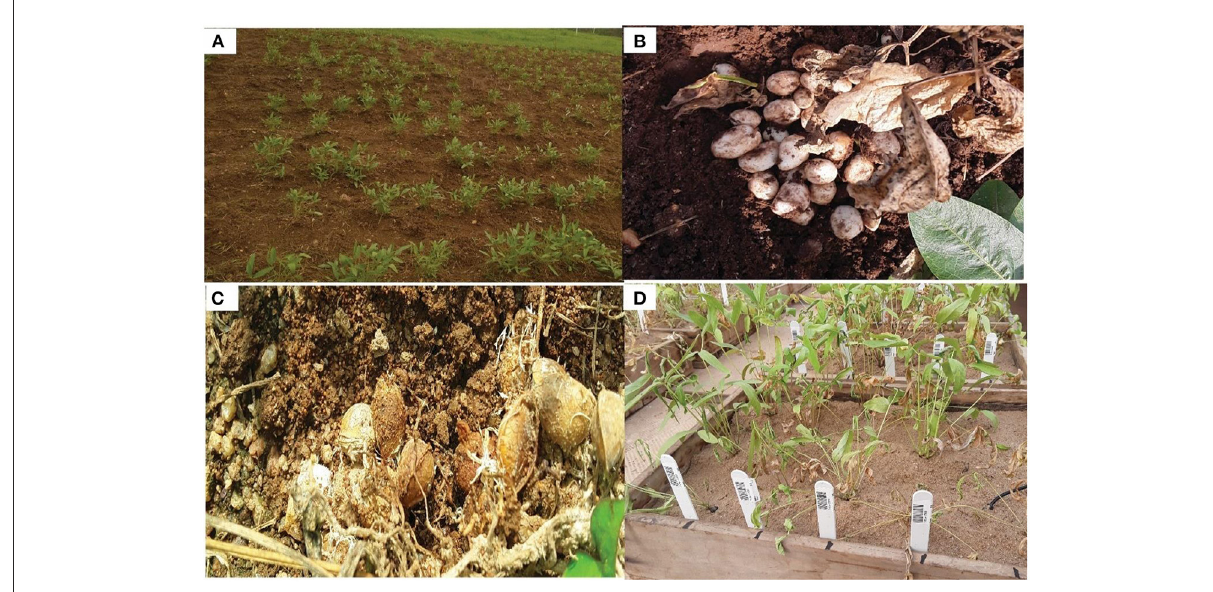
FIGURE1 (A) Bambara groundnut (BGN) in the field; (B) healthy matured BGN pods during harvest; (C) infected BGN pods; (D) drought stressed BGN plants. [Source: Olanrewaju et al.,